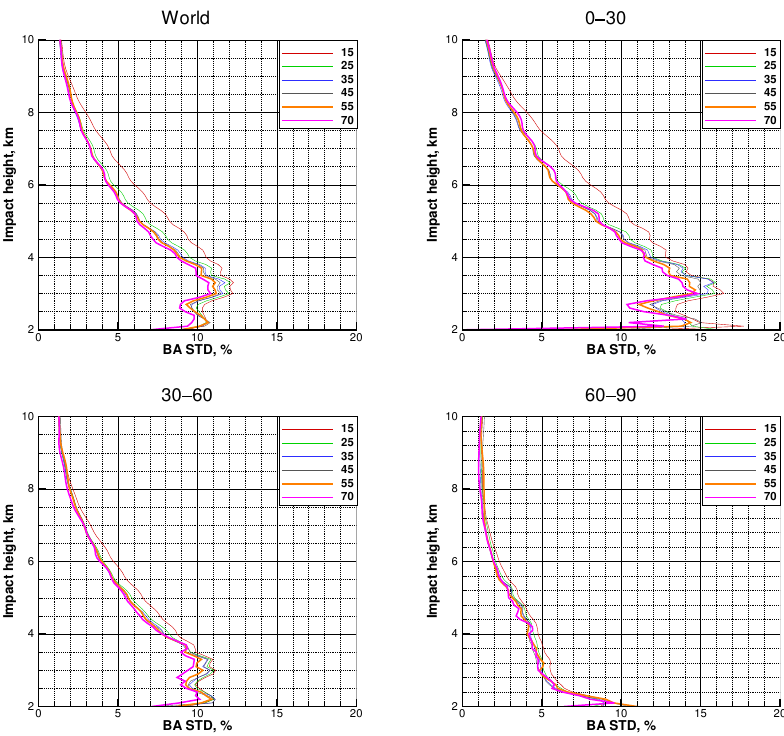
Figure 9. Similar to Figure 3. Spire, standard deviation.